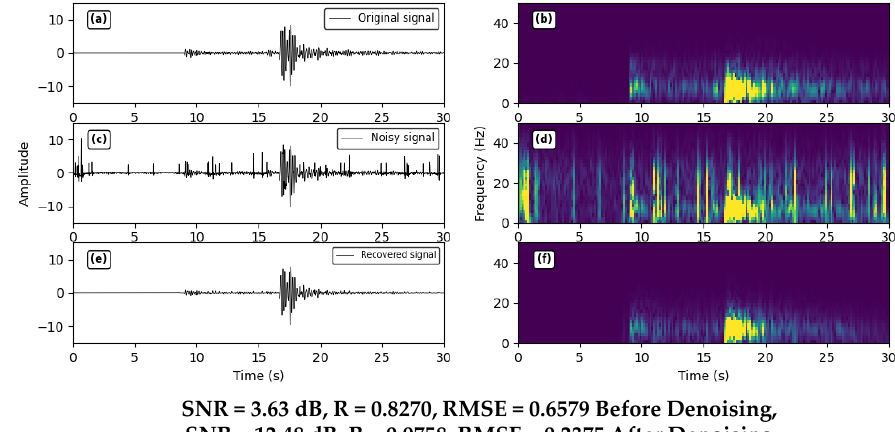
Figure 11. Co-band denoising of spike pulse noise and seismic signals.